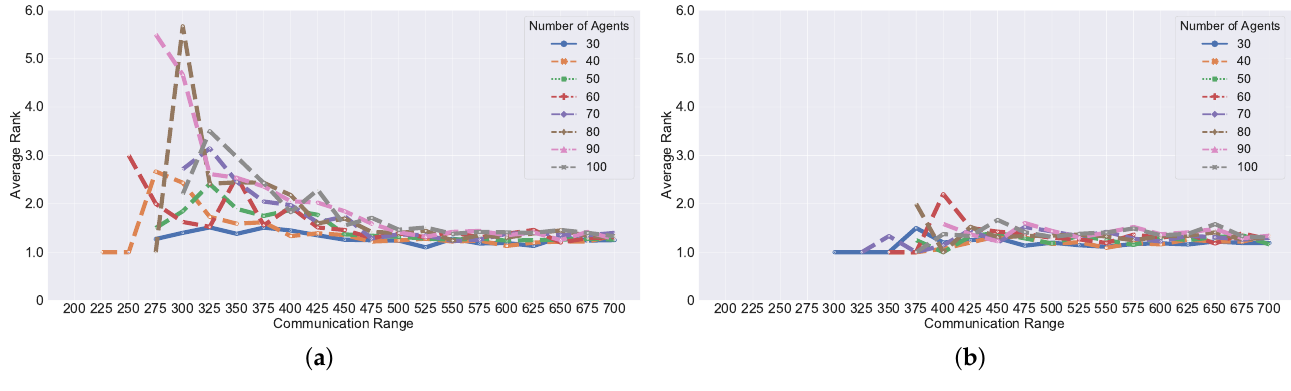
Figure 16. The average rank with half swarm size threshold. ( a ) Our proposed method with respect to different swarm size. ( b ) The Raft-based method with respect to different swarm size.